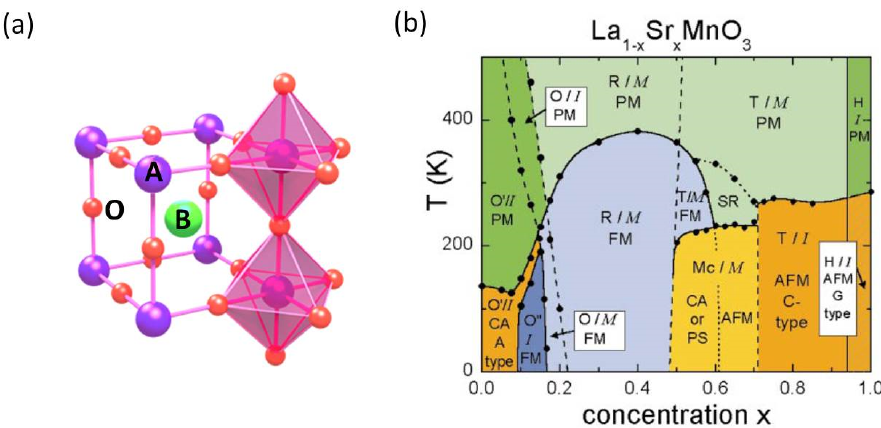
Figure 1. ( a ) Schematic structure model of ABO 3 perovskite. ( b ) Phase diagram of La 1− x Sr X MnO 3